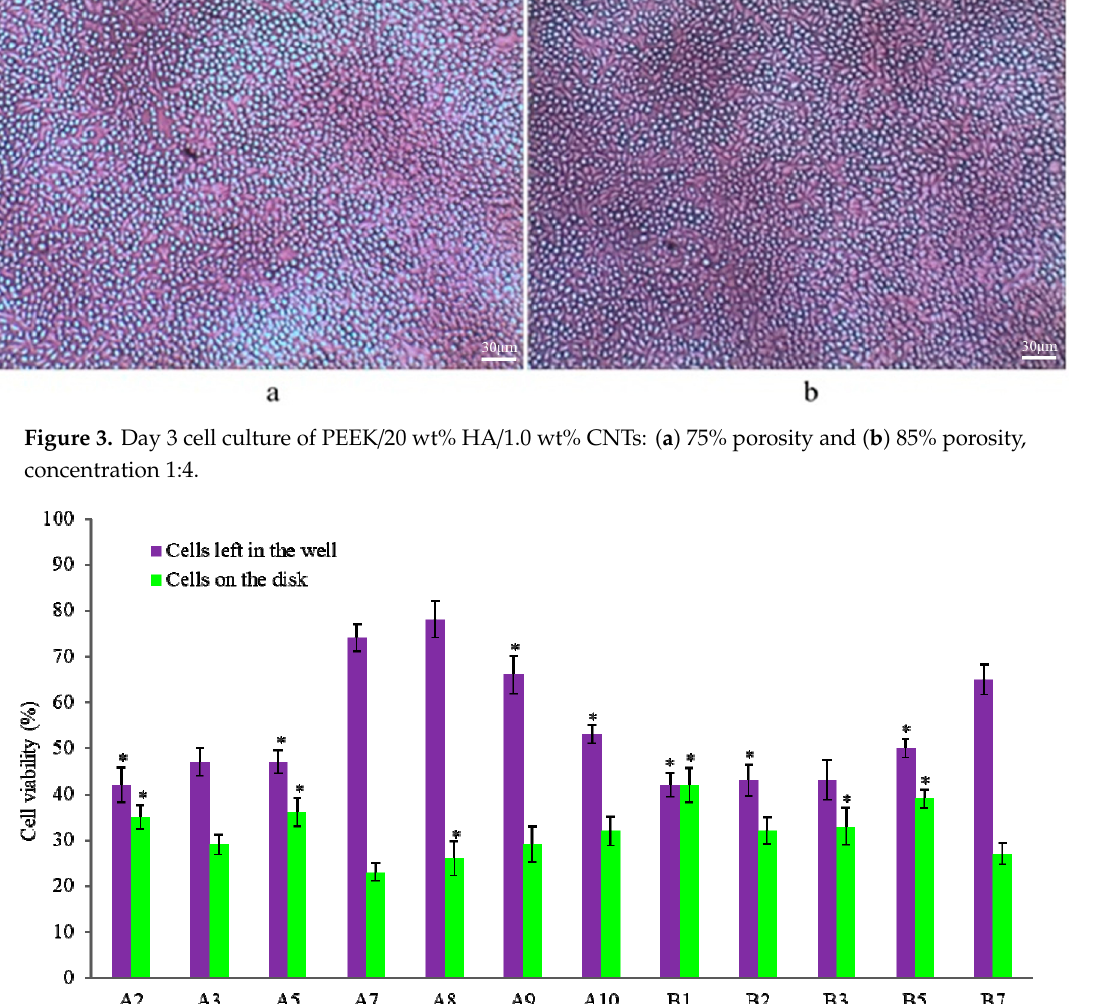
Figure 3. Day 3 cell culture of PEEK/20 wt% HA/1.0 wt% CNTs: ( a ) 75% porosity and ( b ) 85% porosity, concentration 1:4.